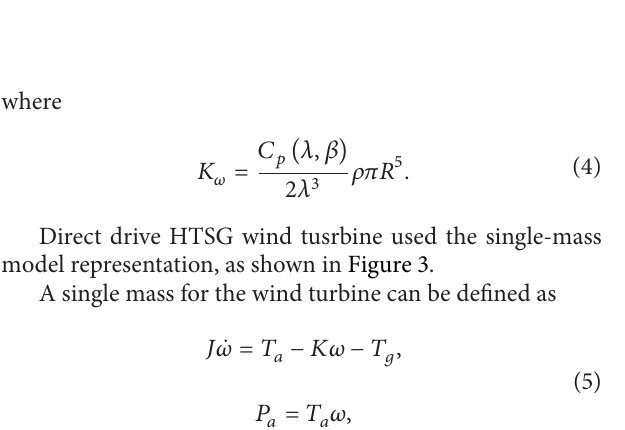
Figure 3: Wind turbine drive